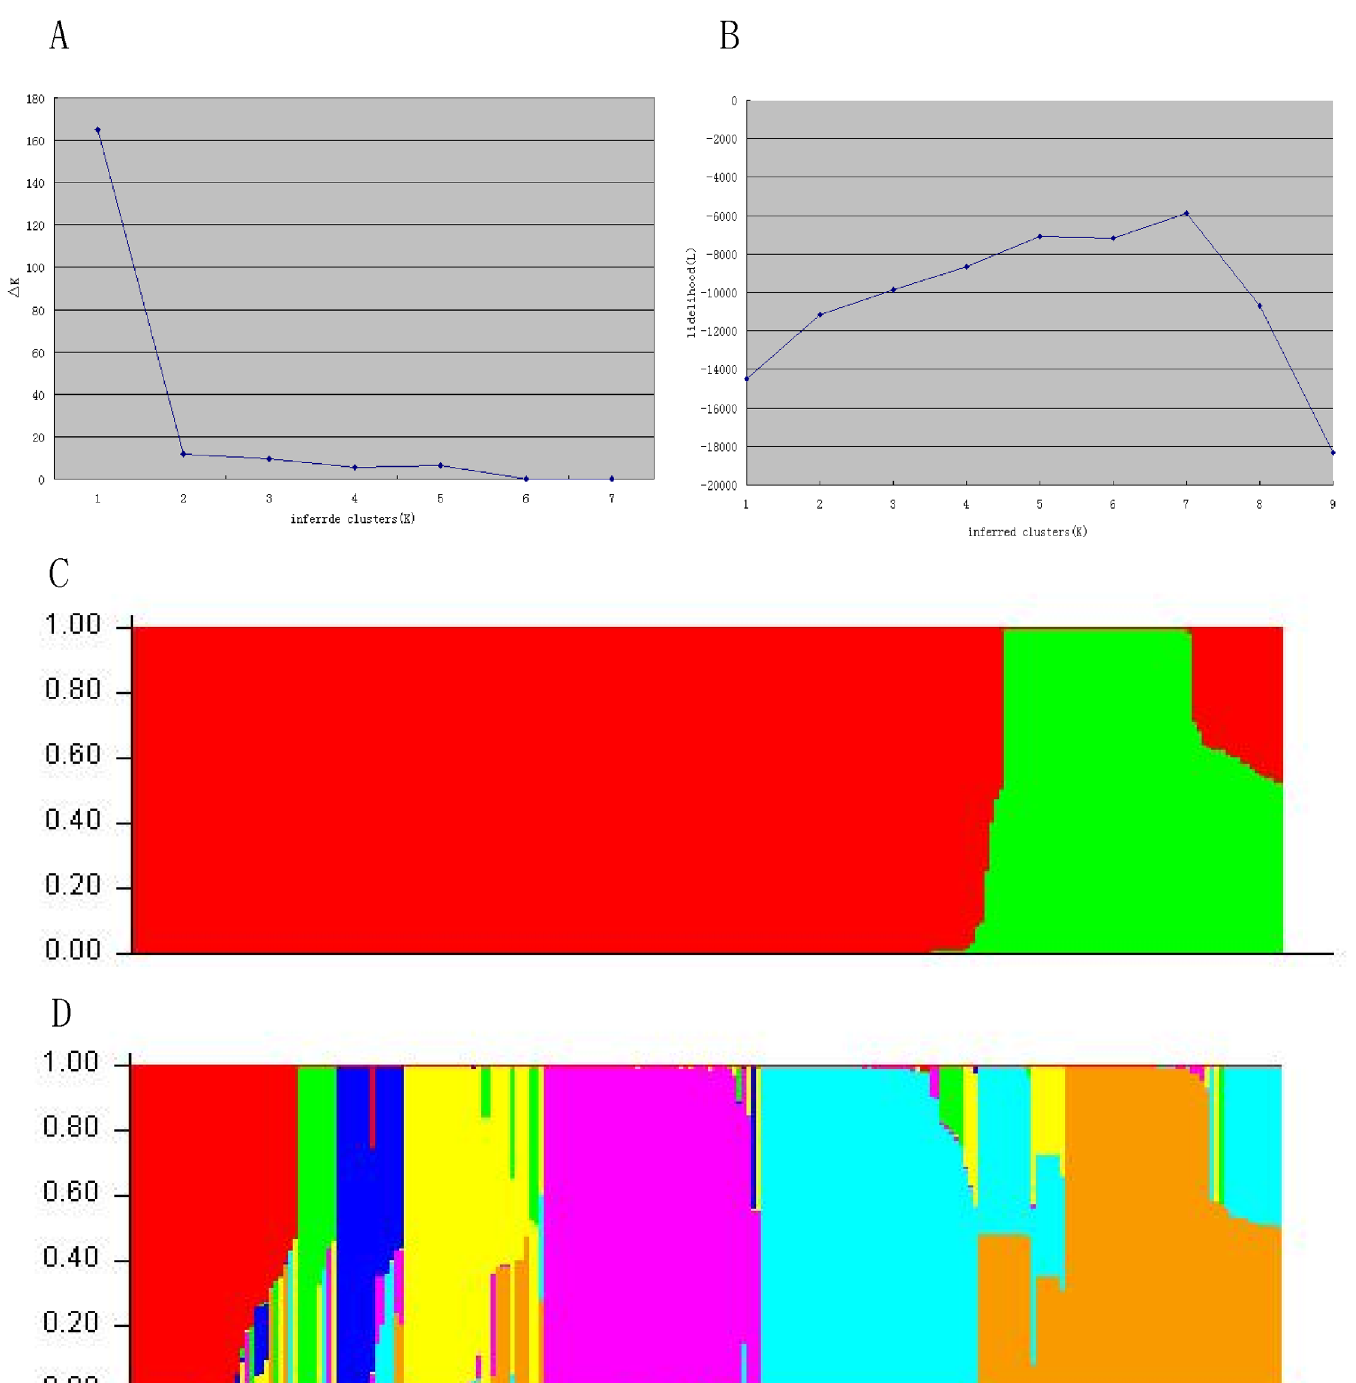
Fig 2. Structure analysis. The median 4 K for 10 runs for each K estimate are shown. A. median likelihood values. B. Population subdivision and the frequency distribution of foxtail millet population in each inferred clusters. Results from both the K = 2 (C) and K = 7 (D) models are shown. Each accession is shown by a thin vertical line that is partitioned into two or seven colored segments. The accessions in which membership probability is < 50% are classified into a “ mixed ” group.